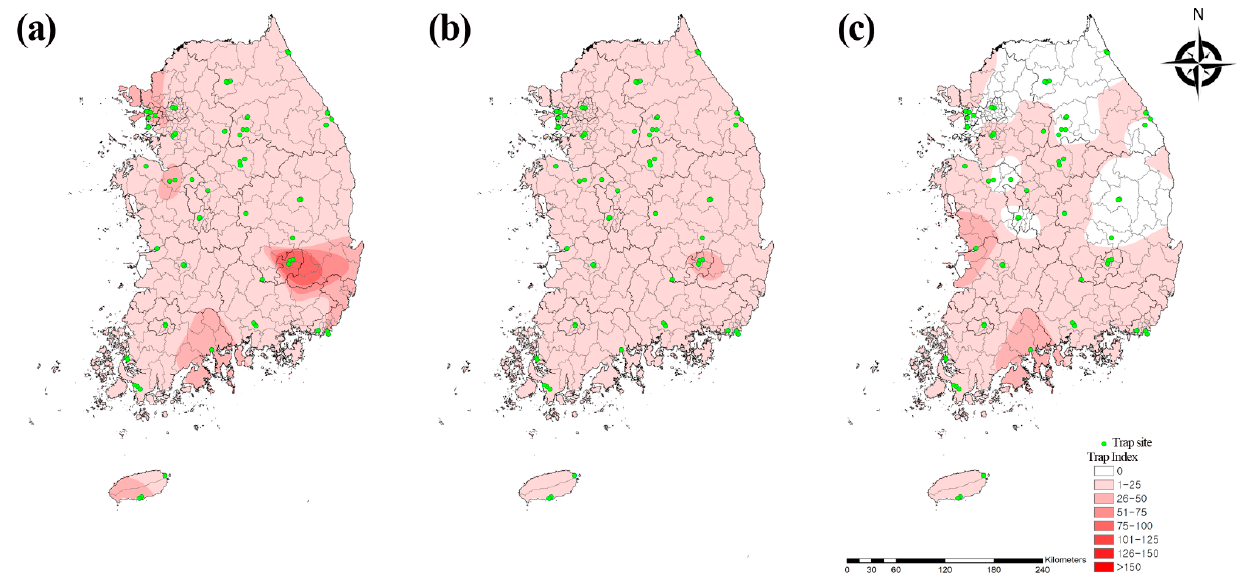
Figure 3. Geographical distribution of three major flavivirus vector mosquito species. ( a ) Culex pipiens complex, ( b ) Aedes albopictus , and ( c ) Culex tritaeniorhynchus collected from traps at 36 collection sites in the Republic of Korea in 2020. Map color indicates TI (0 to > 160). Collection traps are indicated by green dots. TI shows the number of mosquitoes per trap per night.